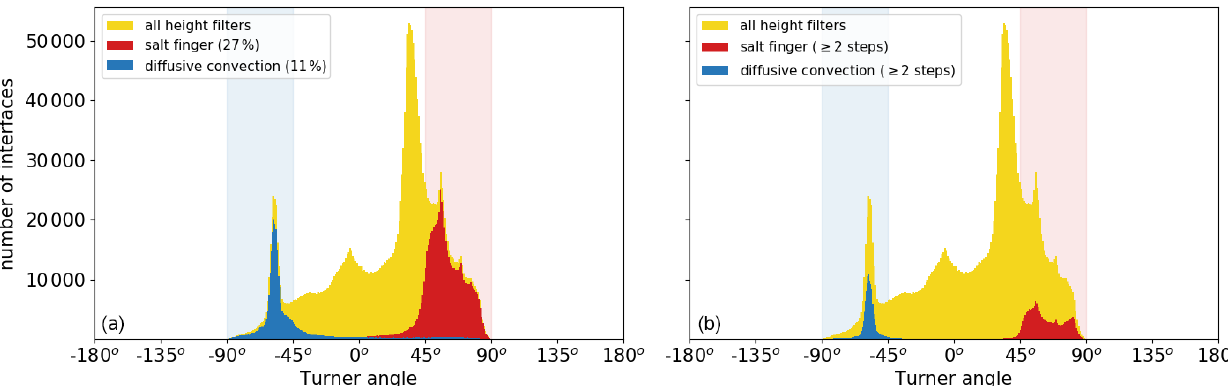
Figure 6. Histogram of the number of detected interfaces as a function of the Turner angle (Tu) after (a) classification of the double-diffusive regime and (b) selection of sequences of the interfaces. Each panel shows the data remaining compared to the interfaces detected based on interface height requirement shown in Fig. 5d (yellow shading). Vertical shaded bands correspond to Turner angles in the diffusive-convective (blue) and salt-finger (red)